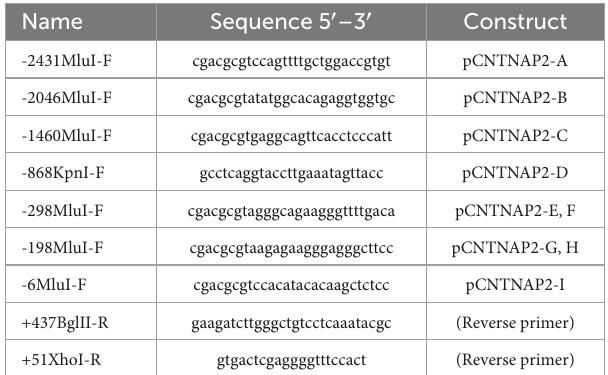
TABLE 1 Primers for cloning human CNTNAP2 promoter constructs in the pGL3-Basic